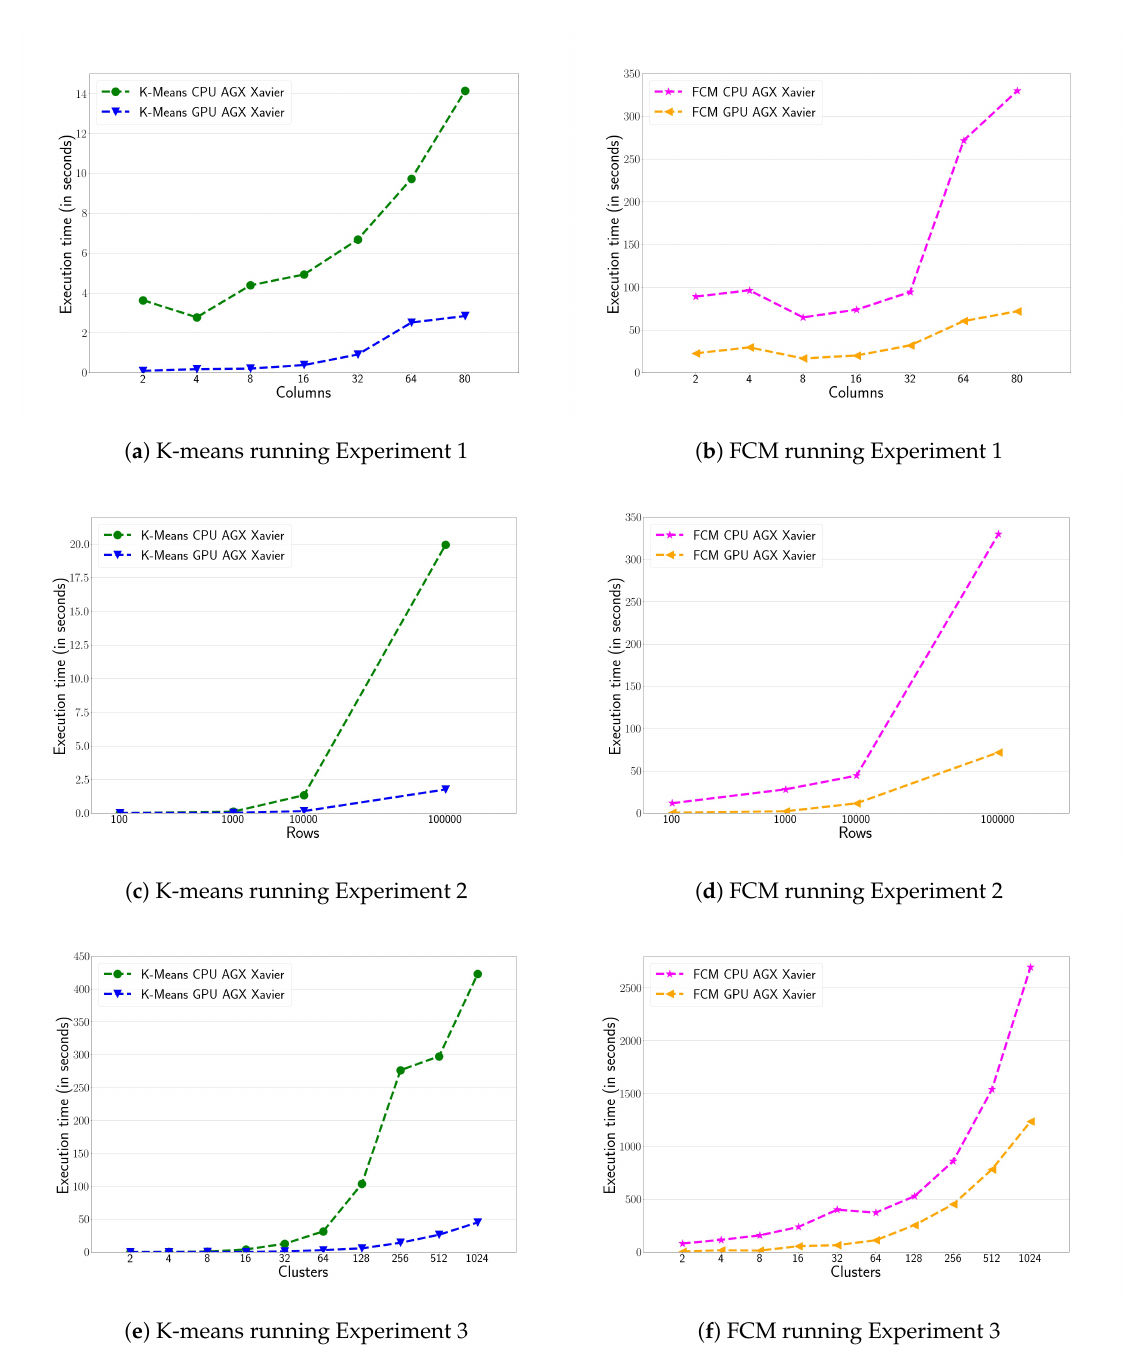
Figure 4. Execution time (in seconds) for the three benchmarks for K-means and FCM algorithms on the NVIDIA AGX